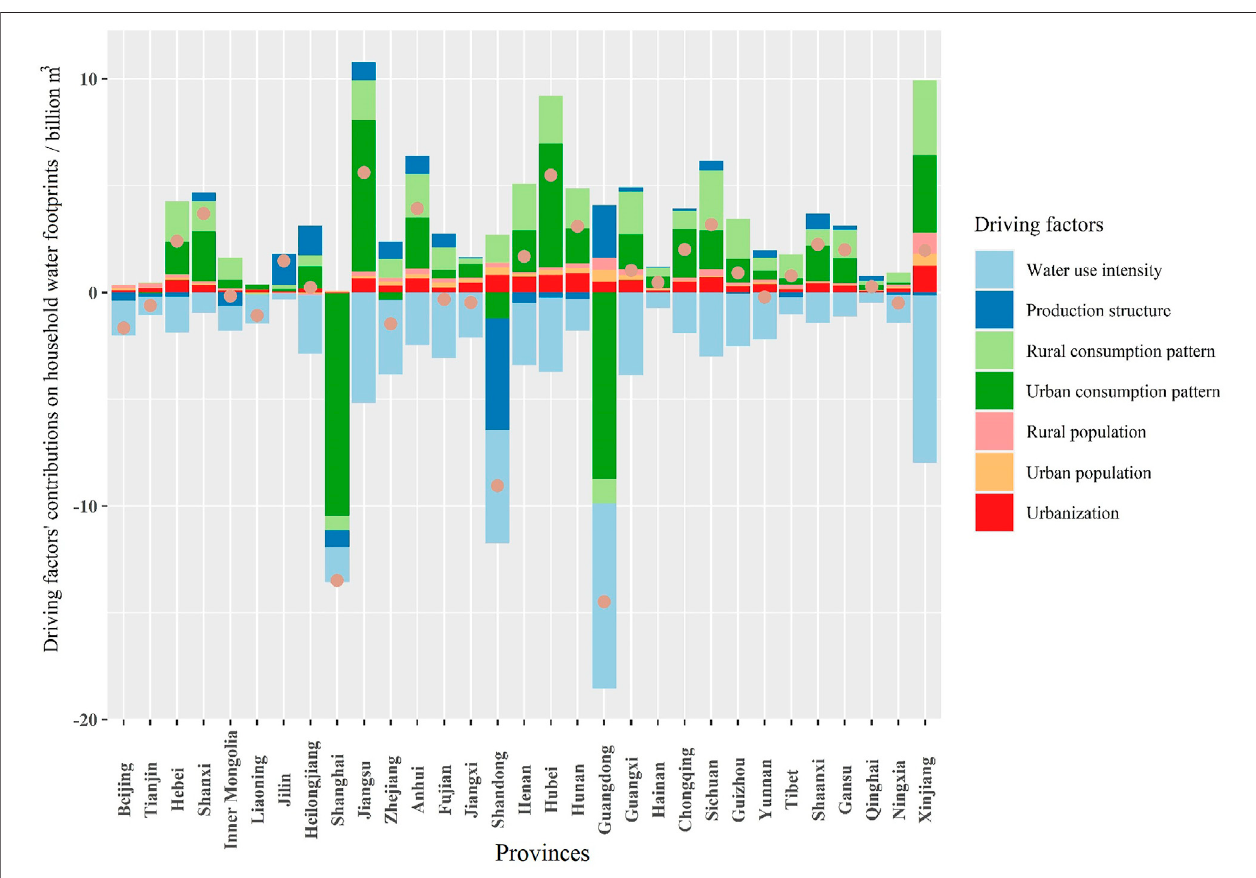
FIGURE 4 | The contribution of driving factors to the provincial household water footprints.